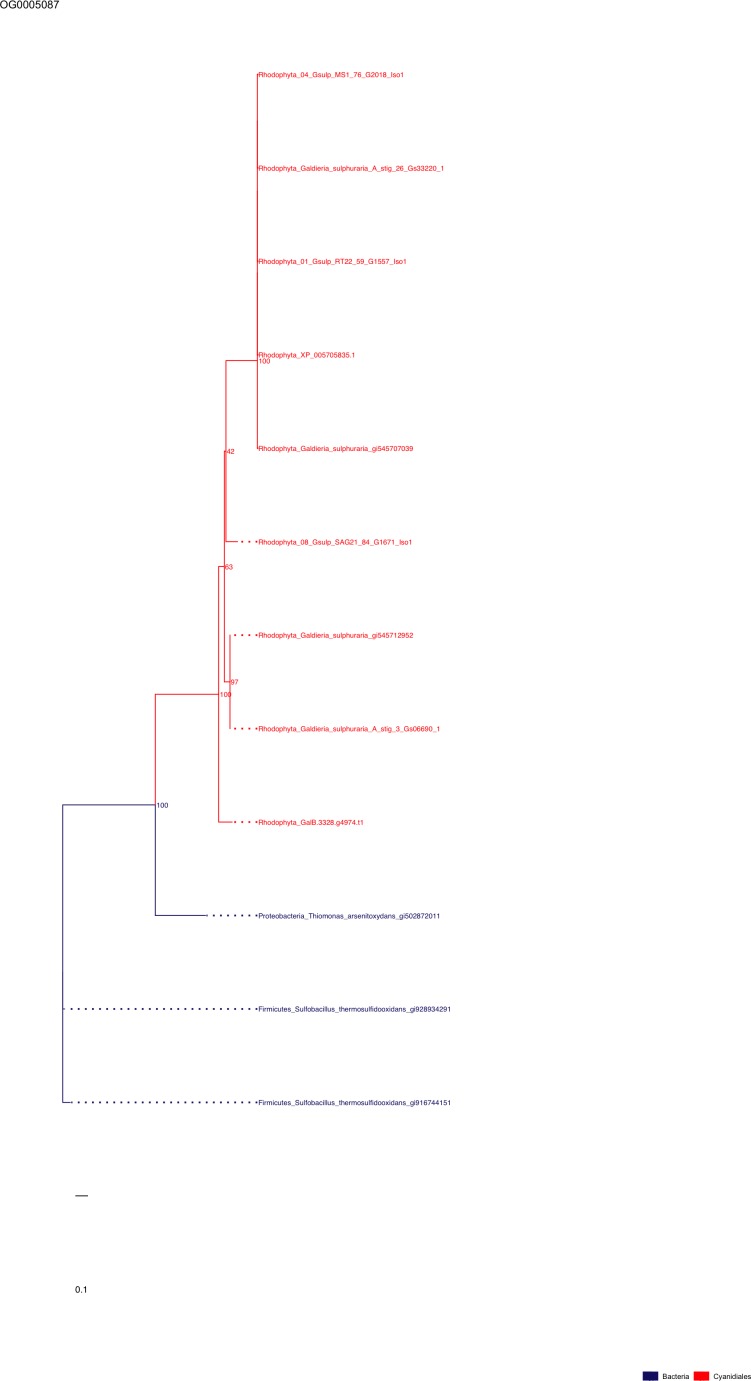
Sequence tree of orthogroup OG0005087.The tree is based on amino acid sequences. Archaea (yellow), Bacteria (blue), Cyanidiales (red), Eukaryotes including other red algae (green). Branches containing Cyanidiales sequences are highlited in red.